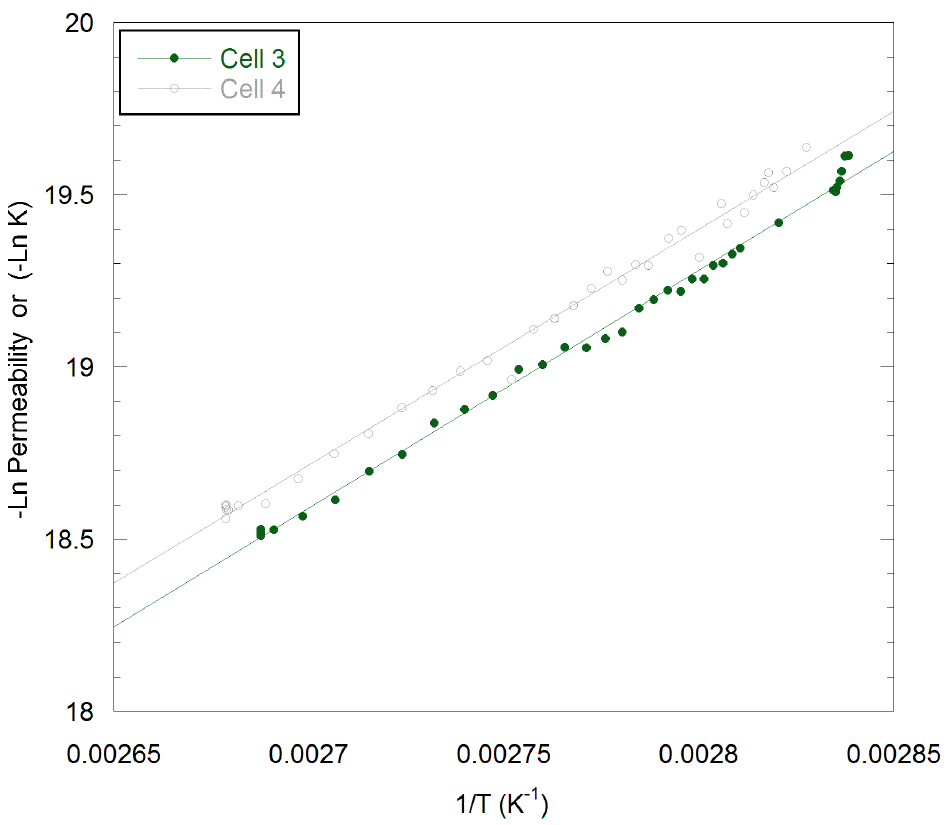
Figure 6. Variation in permeated levels of CO 2 through PPS with inverse of temperature for two independent runs. Data taken from Figure 4.